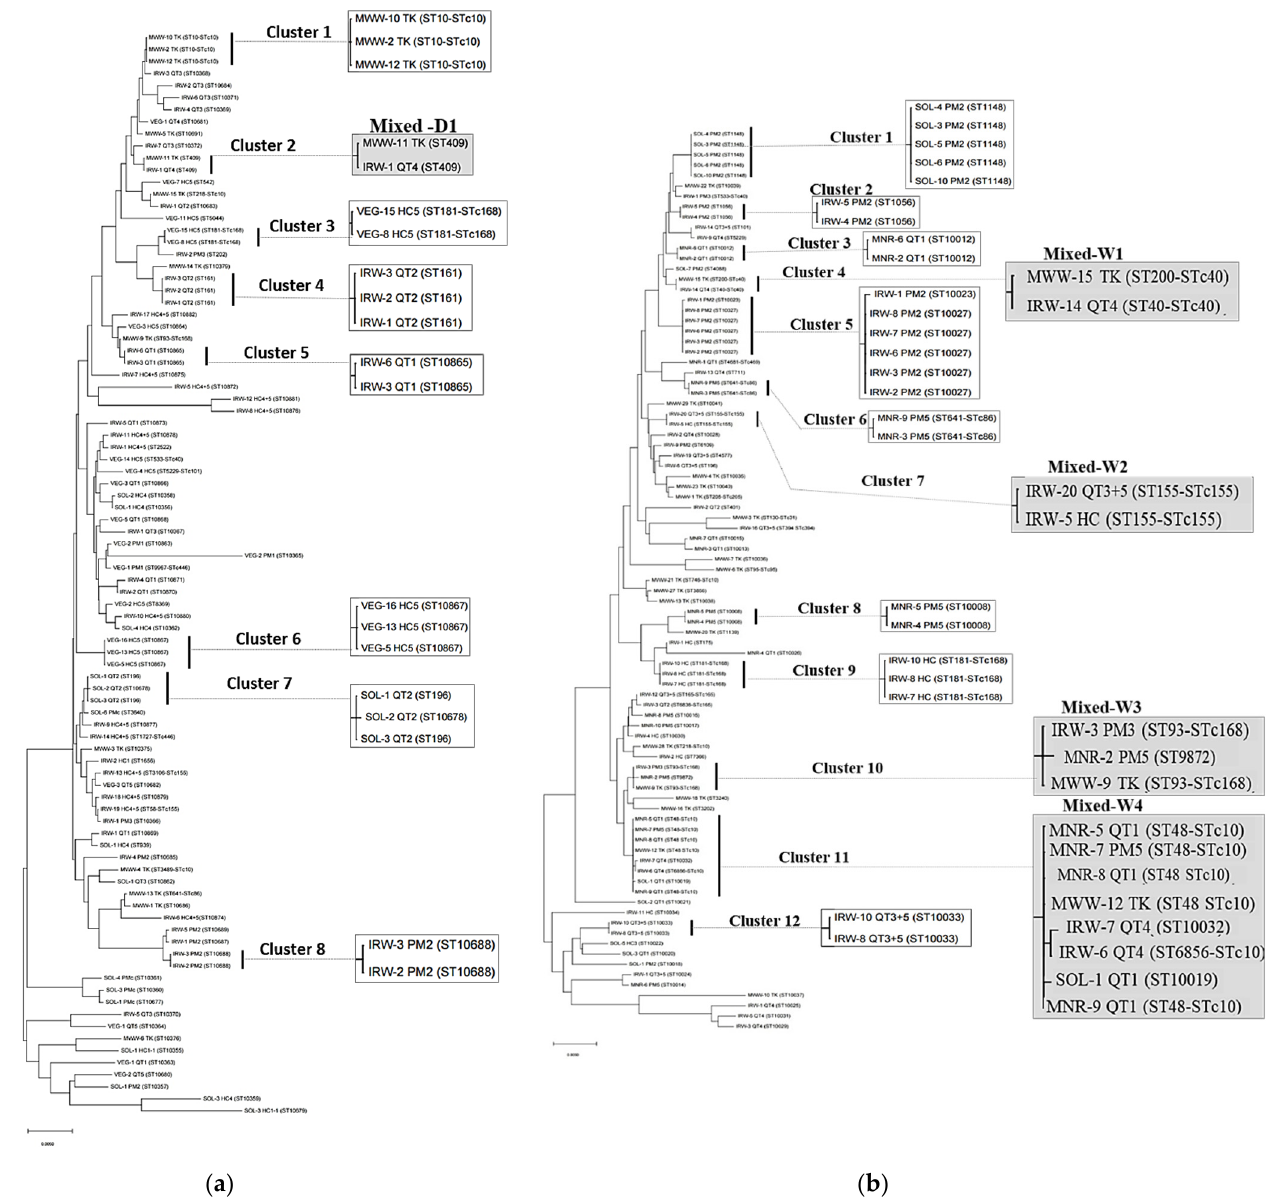
Figure 4. Phylogenetic tree constructed using the neighbor-joining tree method with Kimura 2-parameter model for E. coli isolates from ( a ) municipal wastewater (MWW), irrigation water (IRW), soil (SOL), and vegetable (VEG) samples collected during the dry season; ( b ) MWW, IRW, SOL, and manure (MNR) samples collected during the wet season taken from Huong Chu (HC), Phu Mau (PM), and Quang Thanh (QT) communes. Mixed clusters are highlighted in grey. For the two unrooted trees we constructed using MEGA-X software, the scale bars show a 5% difference between sequences aimed at finding the relationship among isolates without any need to depict the common ancestor.